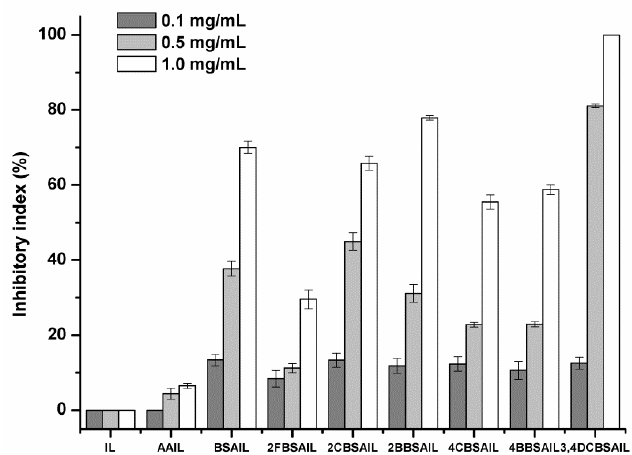
Figure 9. The antifungal activity of inulin, AAIL, and inulin derivatives against Fusarium oxysporum f. sp. cucumerium Owen.